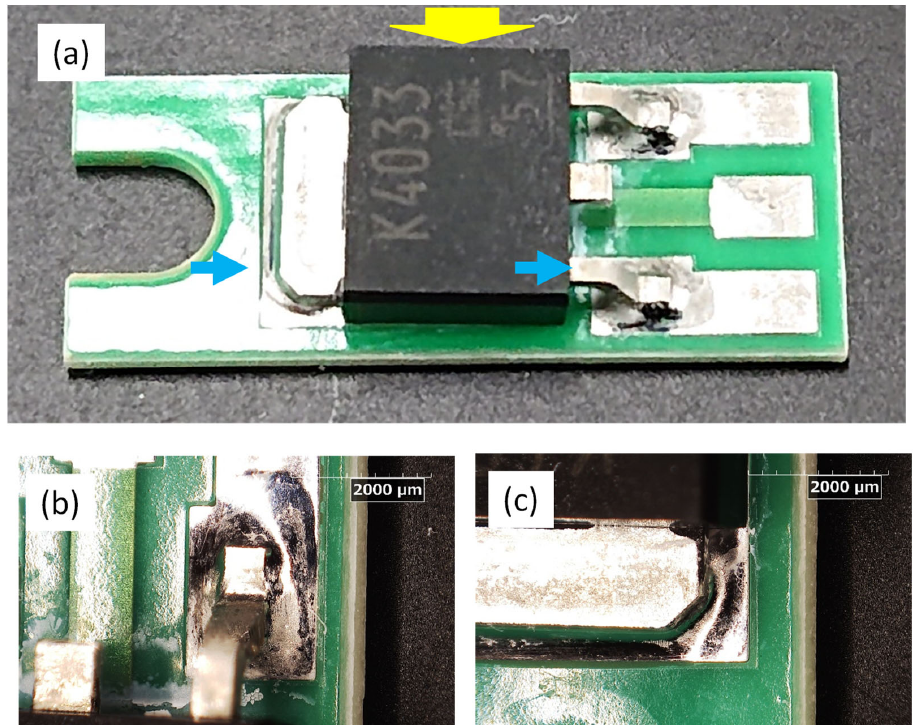
Figure 9. Exterior image of a sample soldered by the conventional reflow. Appearance ( a ) and magnified view ( b , c ) of indicated position in Figure 1a by the blue arrows. A yellow arrow indicates a direction of the shear test.